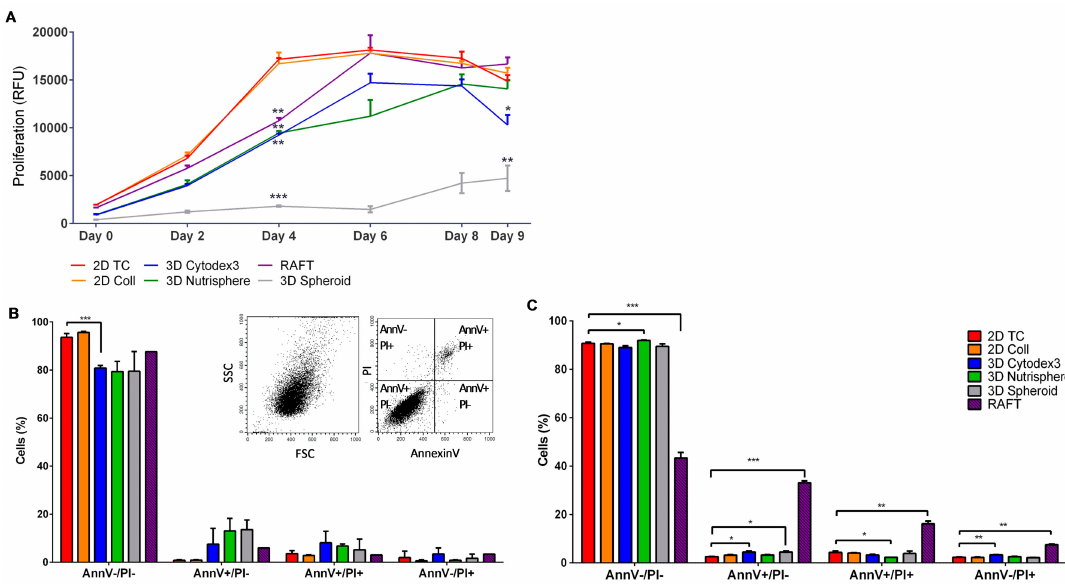
Figure 2. Proliferation rate, viability and apoptosis of A549 cells under di ff erent culture conditions. ( A ) Cells grow slowly in 3D culture than in 2D cultures on culture day 4 (3D spehorids p ≤ 0.0001; RAFT, 3D Cytodex3 and 3D Nutrisphere p ≤ 0.01), but on day 9 only the 3D Spheroid ( p ≤ 0.01) and 3D Cytodex3 ( p ≤ 0.05) showed significantly lower cell numbers than 2D cultures. (n = 3, paired t-test). The viability of cells (AnnV − / PI − living population) remained around 80–90% at day 4 ( B ) and day 9 ( C ), only RAFT culturing resulted in 50% decrease in viability at day 9. Insert shows representative dot plots of single cells for SSC-FSC (Side scatter-Forward scatter, B left insert) and for quadrants detecting living cells (AnnV − / PI − ), early apoptotic cells (AnnV +/ PI-), late apoptotic cells (AnnV +/ PI + ) and necrotic cells (AnnV − / PI + ) (B right insert). Data are mean ± SD of three replicates.